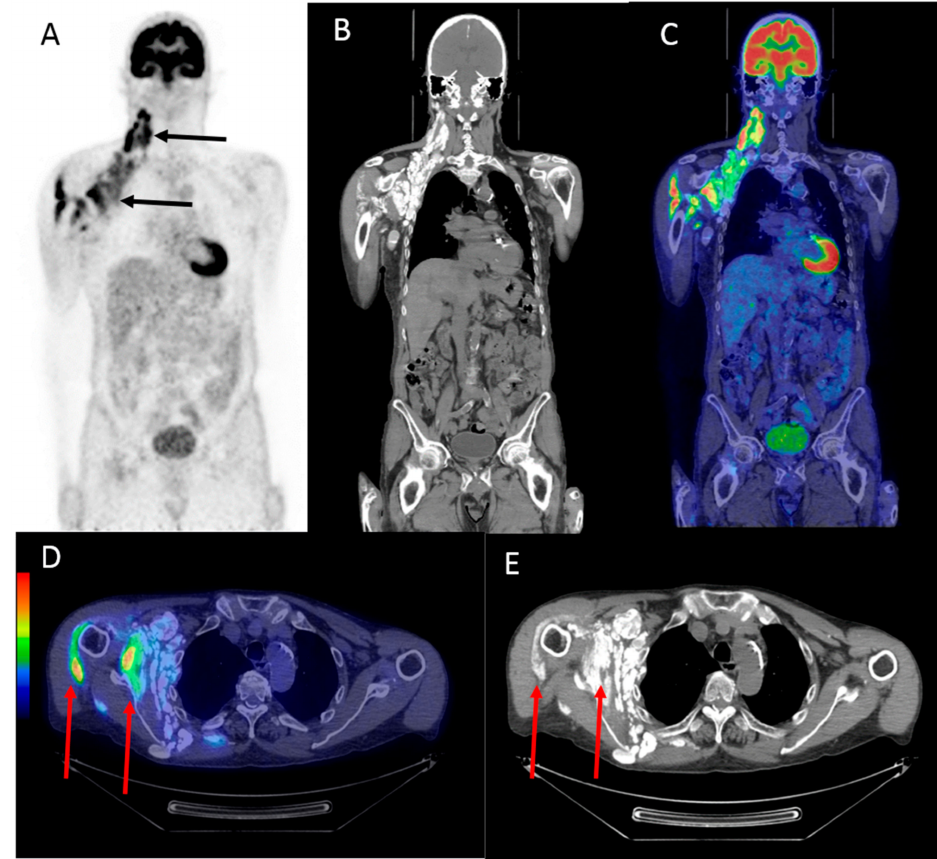
Figure 1. The maximum intensity projection (MIP) of the 18 F-Fludeoxyglucose ( 18 F-FDG) positron emission tomography (PET) image in the anterior view ( A ) showing multiple lesions with high 18 F-FDG uptake located on the right side of the neck, around the right shoulder, and in the right axillar region (black arrows). A coronal computed tomography (CT) image ( B ) and a fused coronal image ( C ) of the head, neck, and upper body showing the same regions with high 18 F-FDG uptake seen in the anterior view ( A ). Fused transversal images ( D ) and transversal CT images ( E ) showing the intramuscular high 18 F-FDG uptake in the right axillary region (red